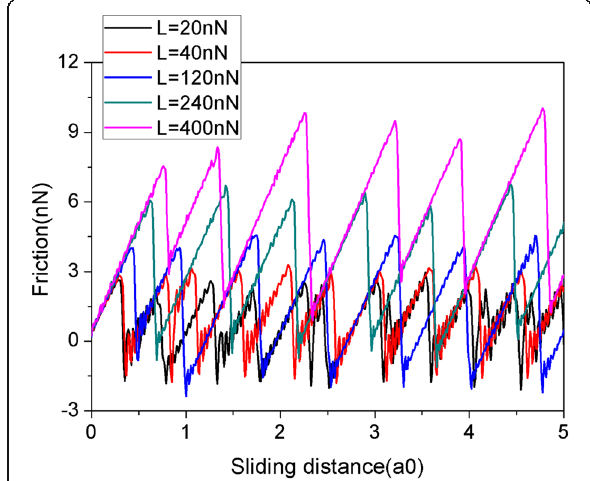
Fig. 2 Friction force as a function of sliding distance at various normal loads (L). The flake has a square shape with a size of 5.8 nm. Here, a0 (=9.99 Å) is the lattice spacing of Au(111) along the sliding direction